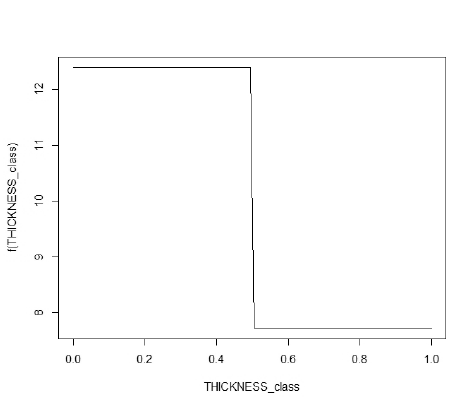
Figure 6: The PDP for classified thickness shows that the thicker strips are less vulnerable for the defect.